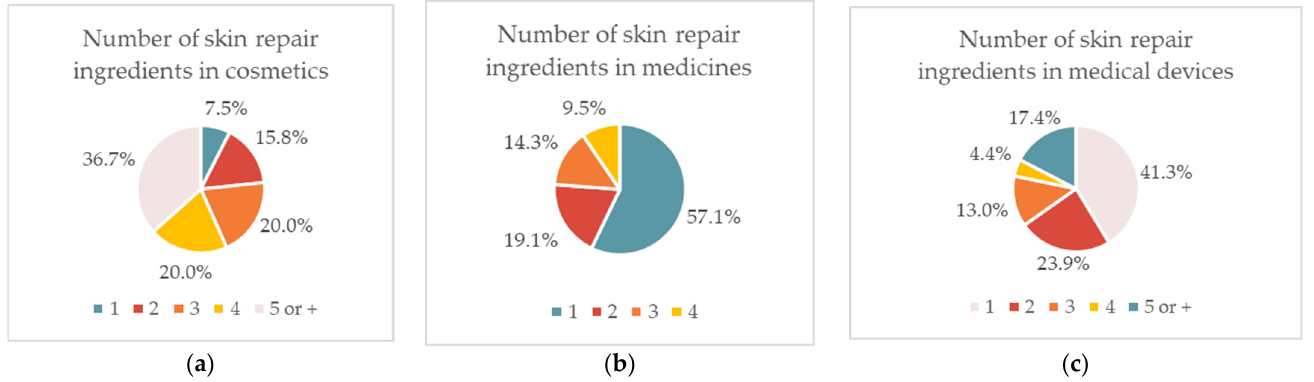
Figure 1. The prevalence of wound repair ingredients or active substances in cosmetic products ( a ), medicines ( b ), and medical devices ( c ).